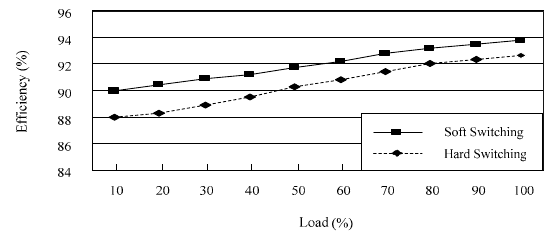
Figure 17. Efficiency comparison. Figure 17. E ffi ciency comparison.